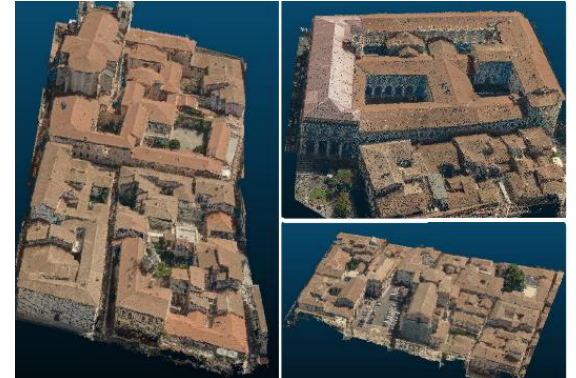
Figure 8. Pre-event 3D point clouds of the sub-blocks considered